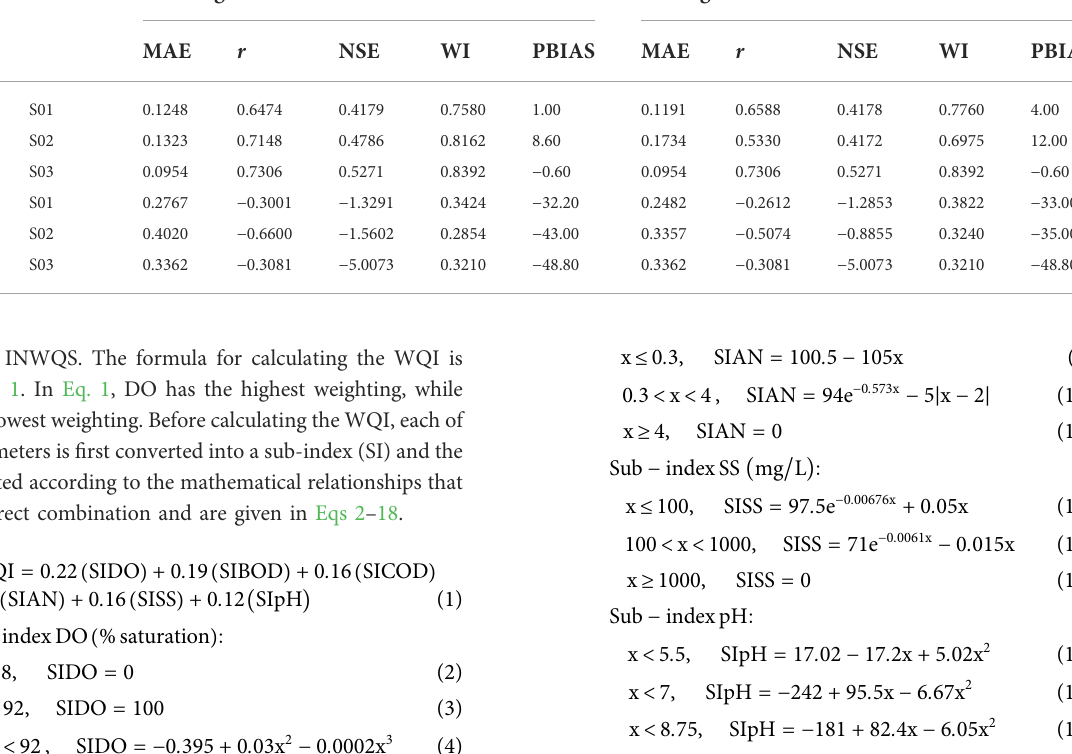
TABLE 12 Performance evaluations for the sixth scenario.